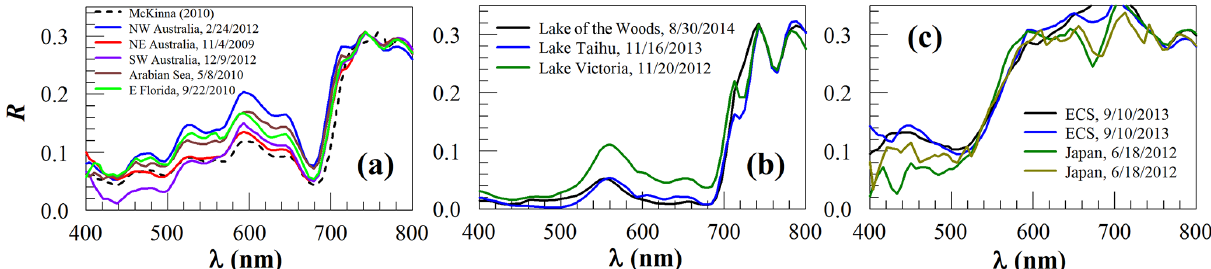
Figure 3. Surface reflectance ( R , dimensionless) of floating scums of microalgae: (a) Trichodesmium , (b) Microcystis , (c) red Noctiluca near the Yangtze of the East China Sea (ECS) and in Sagami Bay of Japan. The dashed line in (a) denotes field-measured R by McKinna